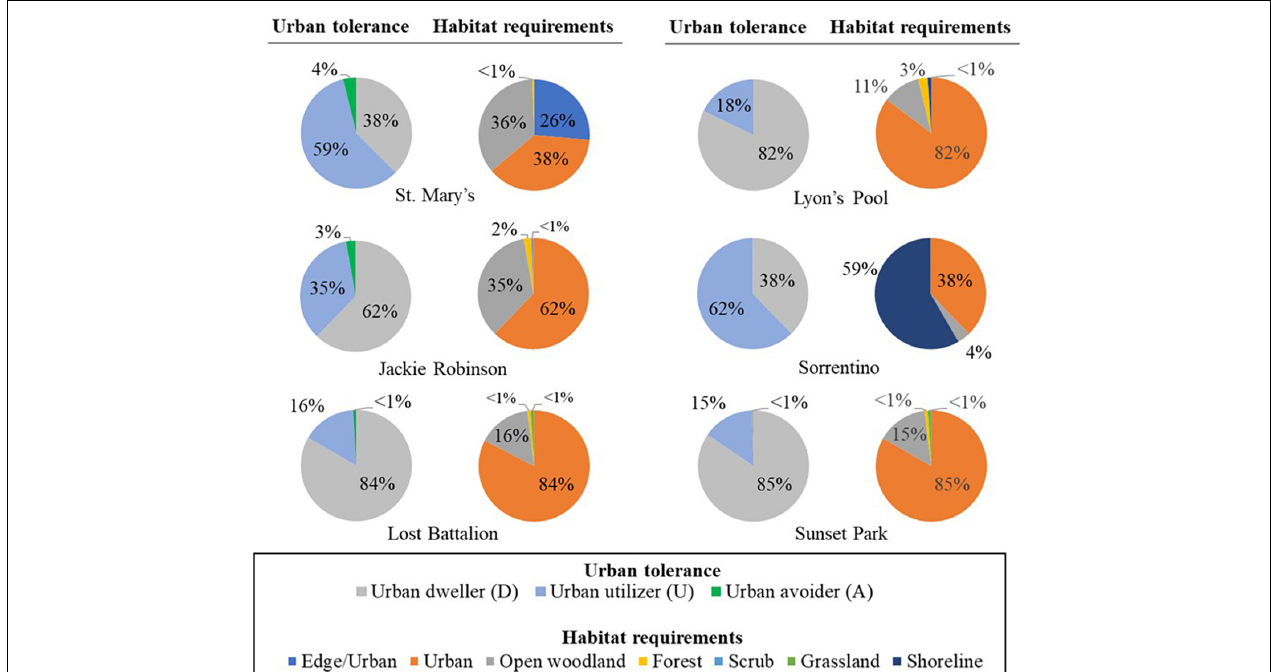
FIGURE 3 | Composition of bird species on six New York City Department of Parks and Recreation recreation center roofs during May of 2010, 2011, 2012, and 2014 based on tolerance to urban landscape and habitat requirements. Species’ urban tolerance was determined using (Johnston, 2001; Fischer et al., 2015; Archer et al., 2019). Habitat requirements for each species was determined using the Birds of North America Online (Poole, 2005).